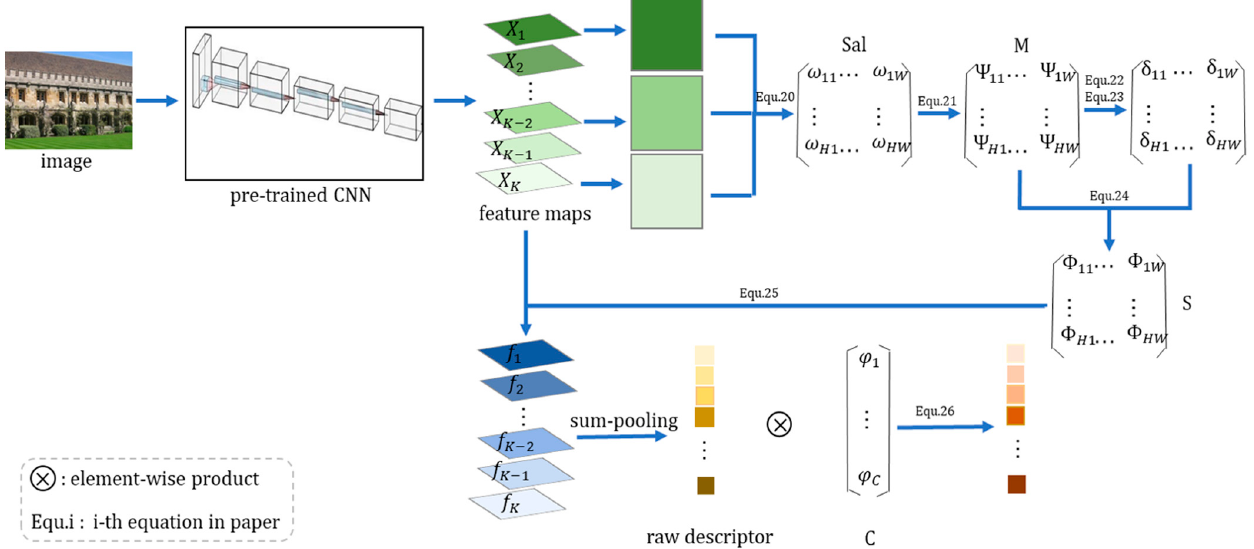
Figure 5. Saliency joint-weighted deep convolutional